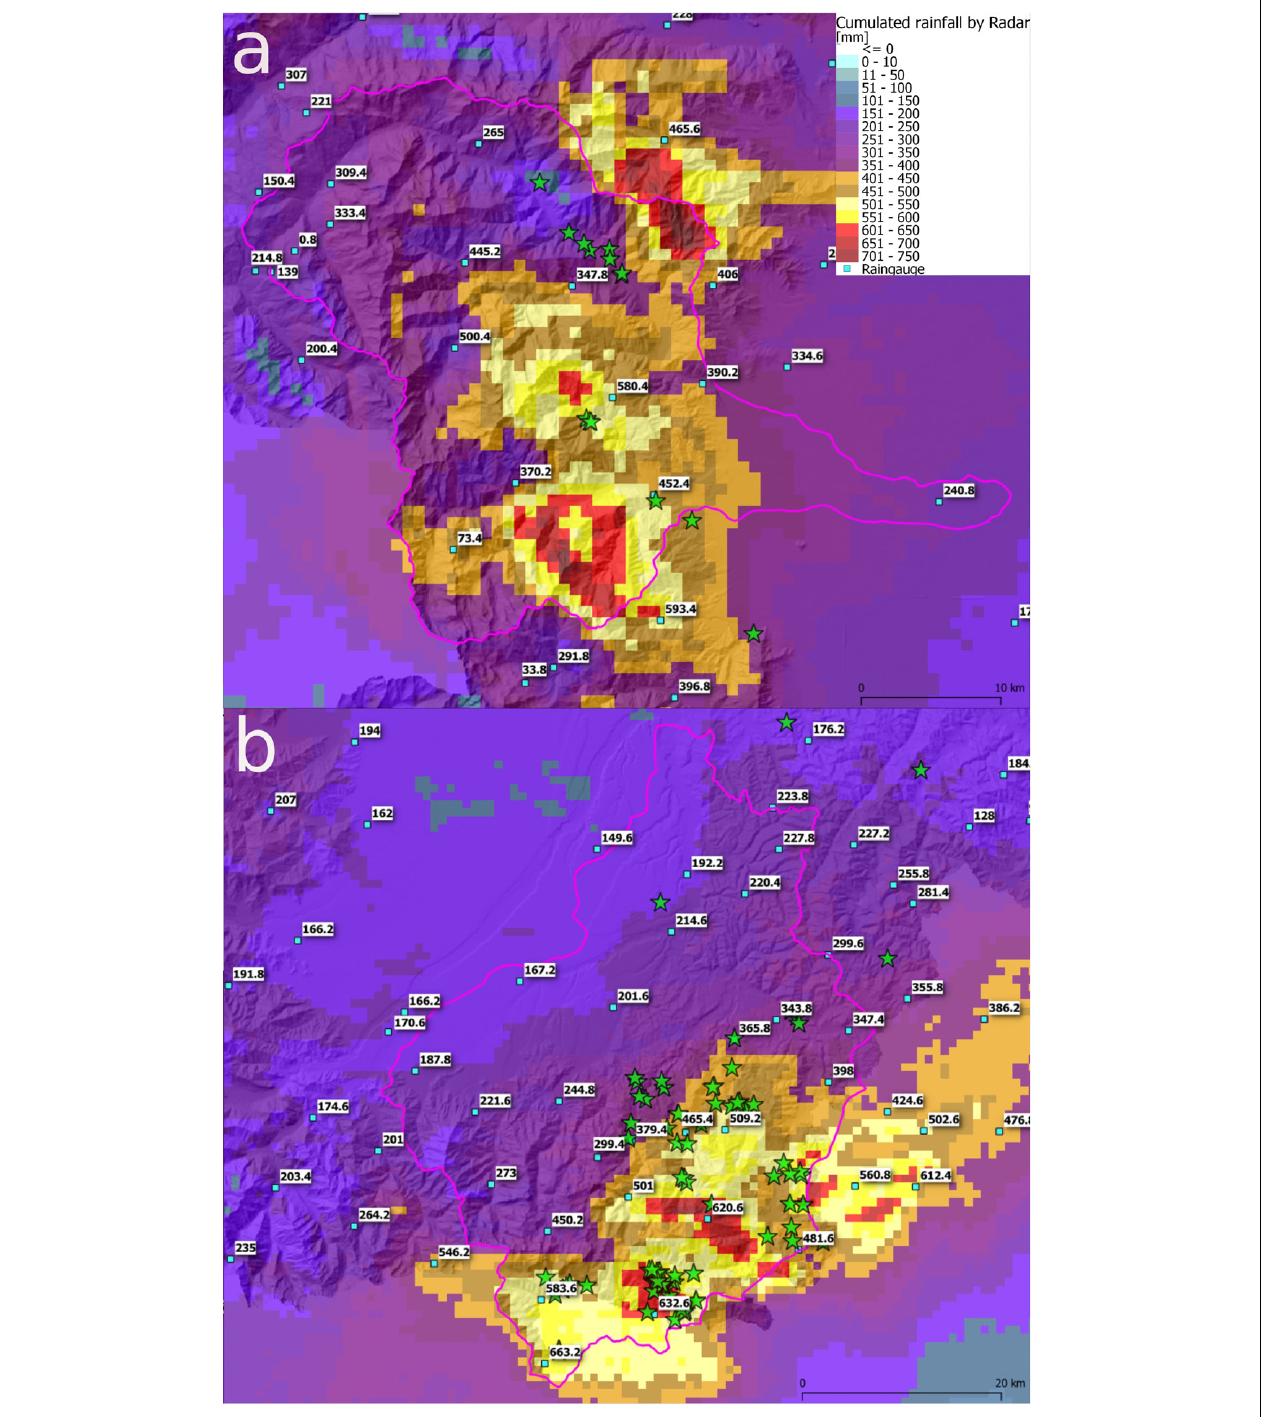
FIGURE 4 | Total rainfall accumulation, estimated by weather radar (grid) and observed by rain gages (values) from 21st to 26th November 2016 in the study areas: (a) Pellice-Chisone; (b) Alto Tanaro.